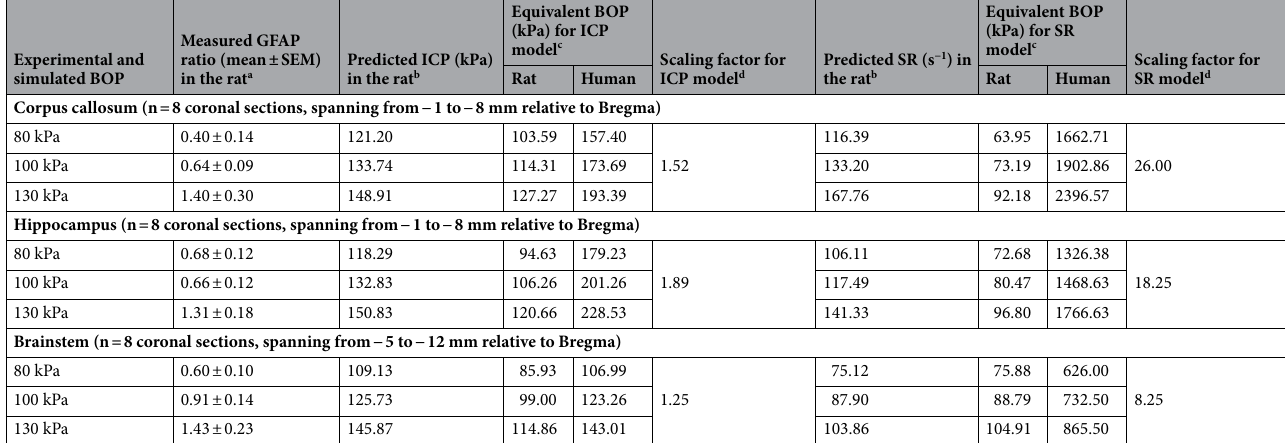
Table 2. Measured changes in glial fibrillary acidic protein (GFAP), model-predicted biomechanical responses, equivalent incident blast overpressures (BOPs), and scaling factors, for three brain regions. BOP blast overpressure, GFAP glial fibrillary acidic protein, ICP intracranial pressure, SEM one standard error of the mean, SR strain rate. a Using the immunohistochemical data for each brain region within a coronal section, we determined a GFAP ratio by dividing the corresponding mean value of the head-only-exposed rats by those of the controls. Next, we computed a per‑BOP estimate (shown in the table) by averaging the corresponding values of all the coronal sections for a given brain region. b Using the rat simulation data for each brain region within a coronal section, we determined the peak 90th percentile of each biomechanical response over the 5-ms simulation. Then, we computed a per‑BOP prediction (shown in the table) by averaging the corresponding values of all the coronal sections for a given brain region. c Using the rat per‑BOP predictions the ratio of the equivalent